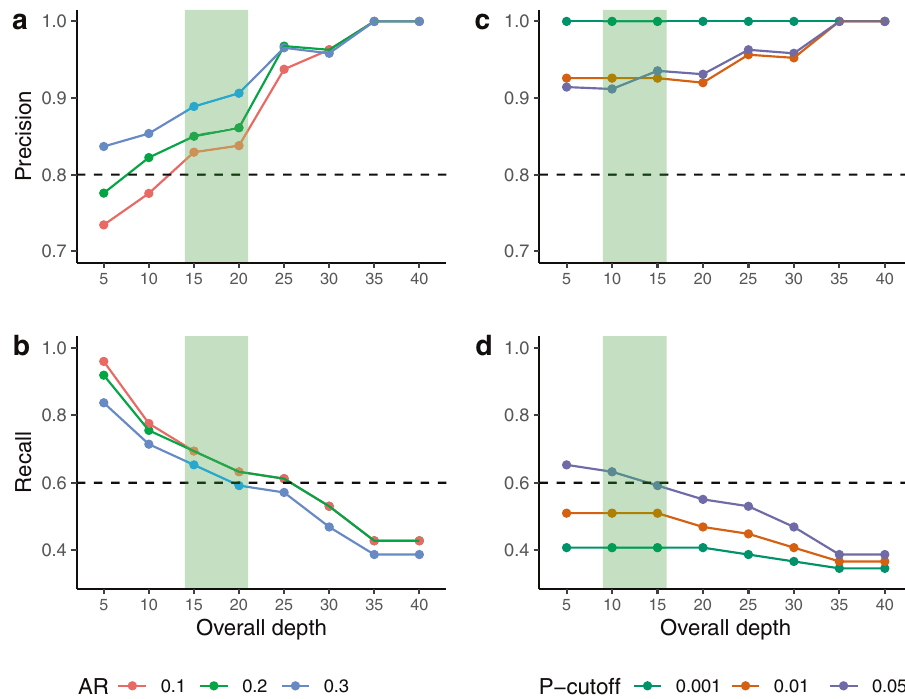
Fig. 4 Precision-recall analysis. Precision and recall analysis on the validated SNV from this study and from Santini et al. ( a ) precision and ( b ) recall using increasing Overall Depth (OD) and three different Allelic Ratio (AR). c Precision and d recall using increasing OD and three P -value cutoffs for the binomial test. The horizontal dashed lines de fi ne the cutoffs of acceptable precision and recall values, while the green areas indicate the best overall